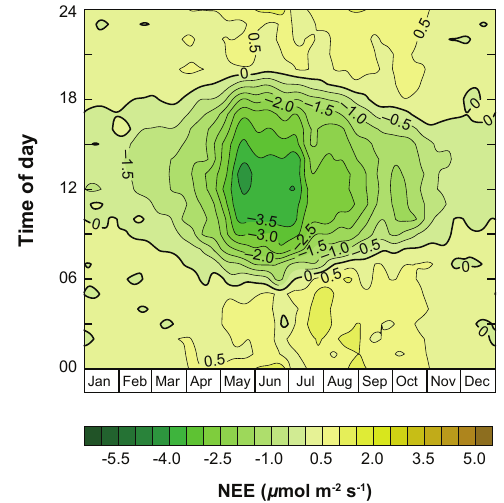
Figure 4. Isopleths of gap-filled NEE (net CO 2 fluxes) from the EC-1 system plotted as a composite in the study year. The graph uses a Gaussian filter of σ = 45 days (which conserves total NEE) to graphically smooth horizontal